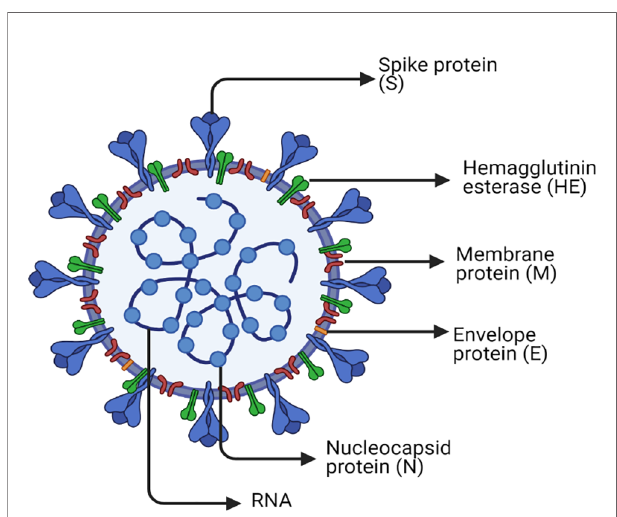
FIGURE 1 | SARS-CoV-2 structure. The fi gure represents a graphical representation of the viral structural proteins spike (S), envelope (E), and membrane (M), which are embedded in the lipid surface. The positive single- stranded RNA is bound to the nucleocapsid protein (N) in the core of the capsid. Each one of these proteins plays a crucial role in the replication life cycle of the virus. The spike protein (S) is the master that supports the attachment and entry of host cell via fusion. The nucleocapsid protein (N) is the one used in transcription, which is included in the replication cycle. The membrane protein (M) that is most abundant on the viral surface drives the viral assembly. Furthermore, the envelope protein (E) has an indispensable role in assembly, host cell membrane permeability, and interactions between the host and virus. Another surface protein is Hemagglutinin esterase dimer (HE) that is found to play a role in cell entry and its infection without having a role in the replication process itself. Finally, the lipid envelope encircles the approximately 30,000 nucleotides, which is the genome of the virus encoding its four structural and many nonstructural proteins